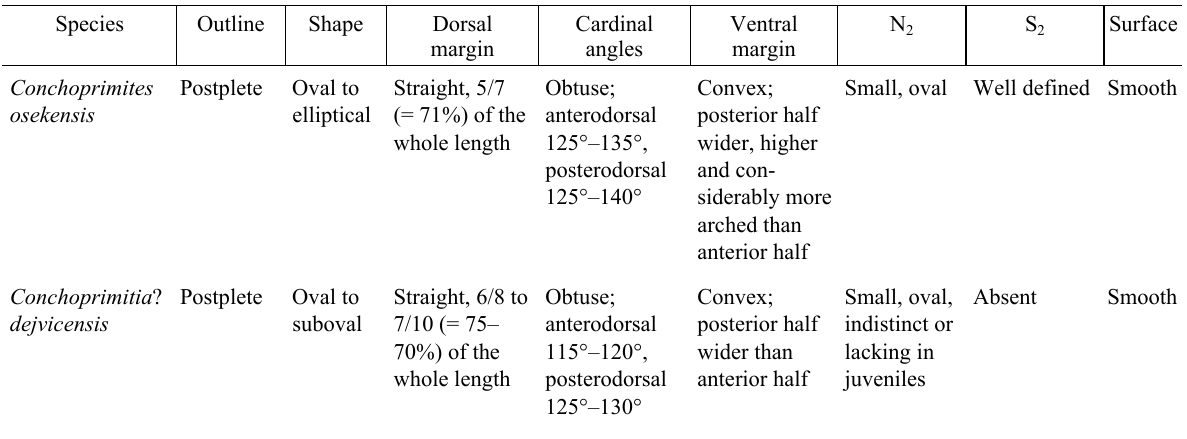
Table 1. Comparison of critical features of Conchoprimites osekensis and Conchoprimitia ? dejvicensis used by P ř ibyl (1979) in his diagnoses